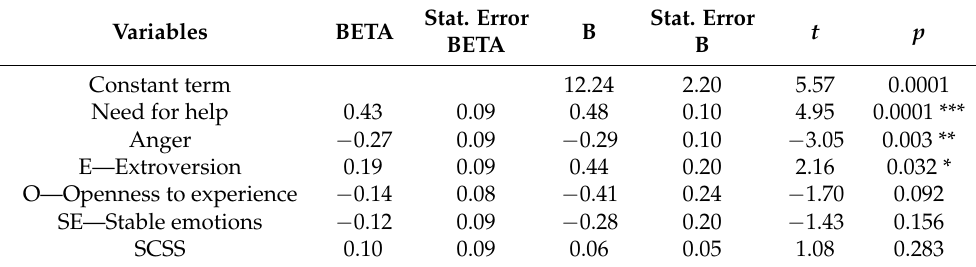
Table 6. Determinants of the ‘seeking support’ variable (SS). Variables